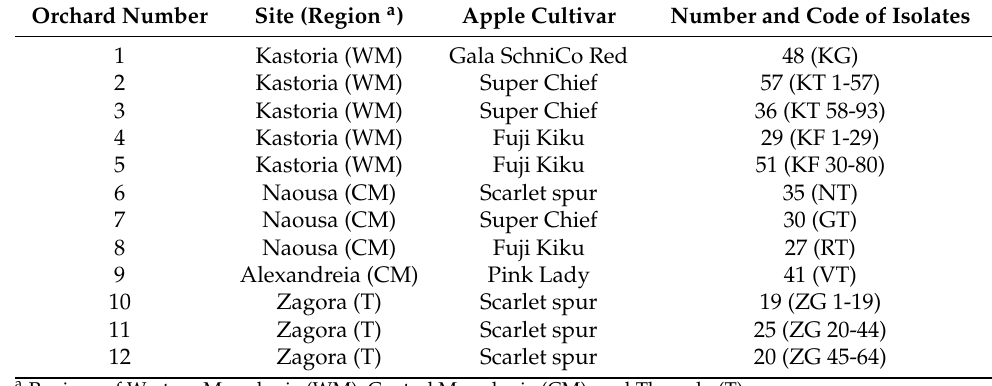
Table 1. Origin of V. inaequalis isolates